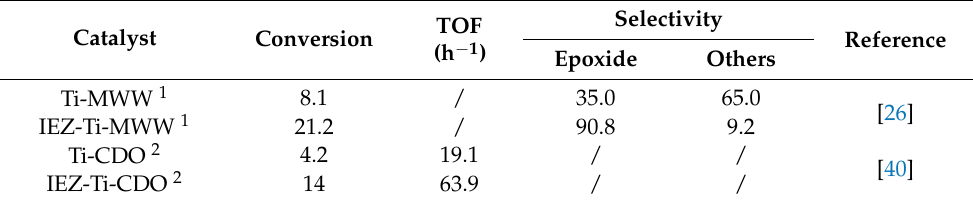
Table 6. Catalytic activity and selectivity in oxidation of cyclohexene over titanosilicates.